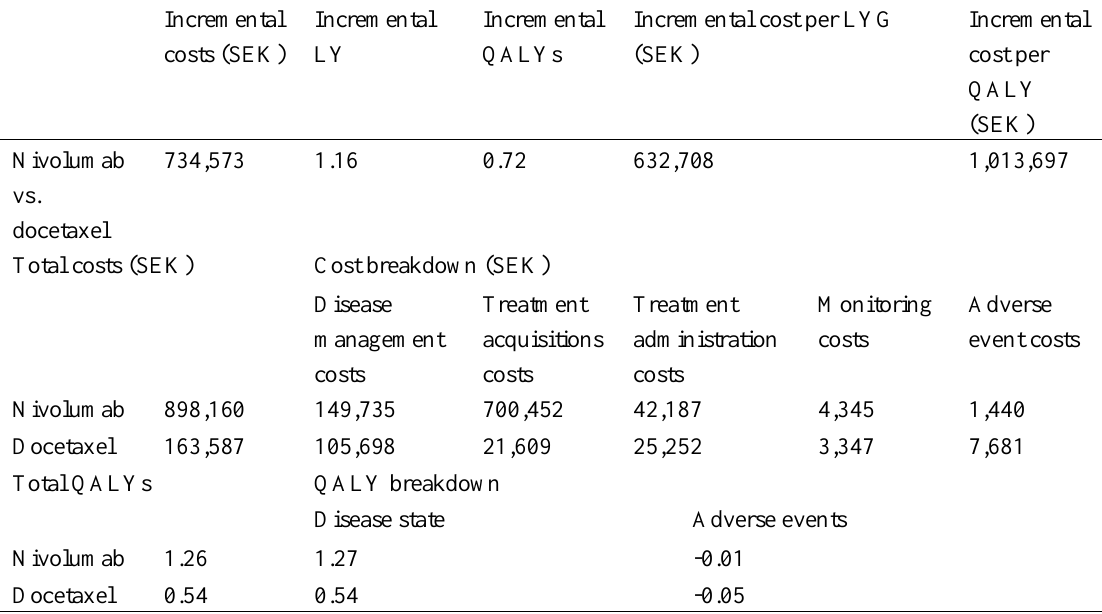
Base-case cost-effectiveness results (squamous analysis; CheckMate 017)